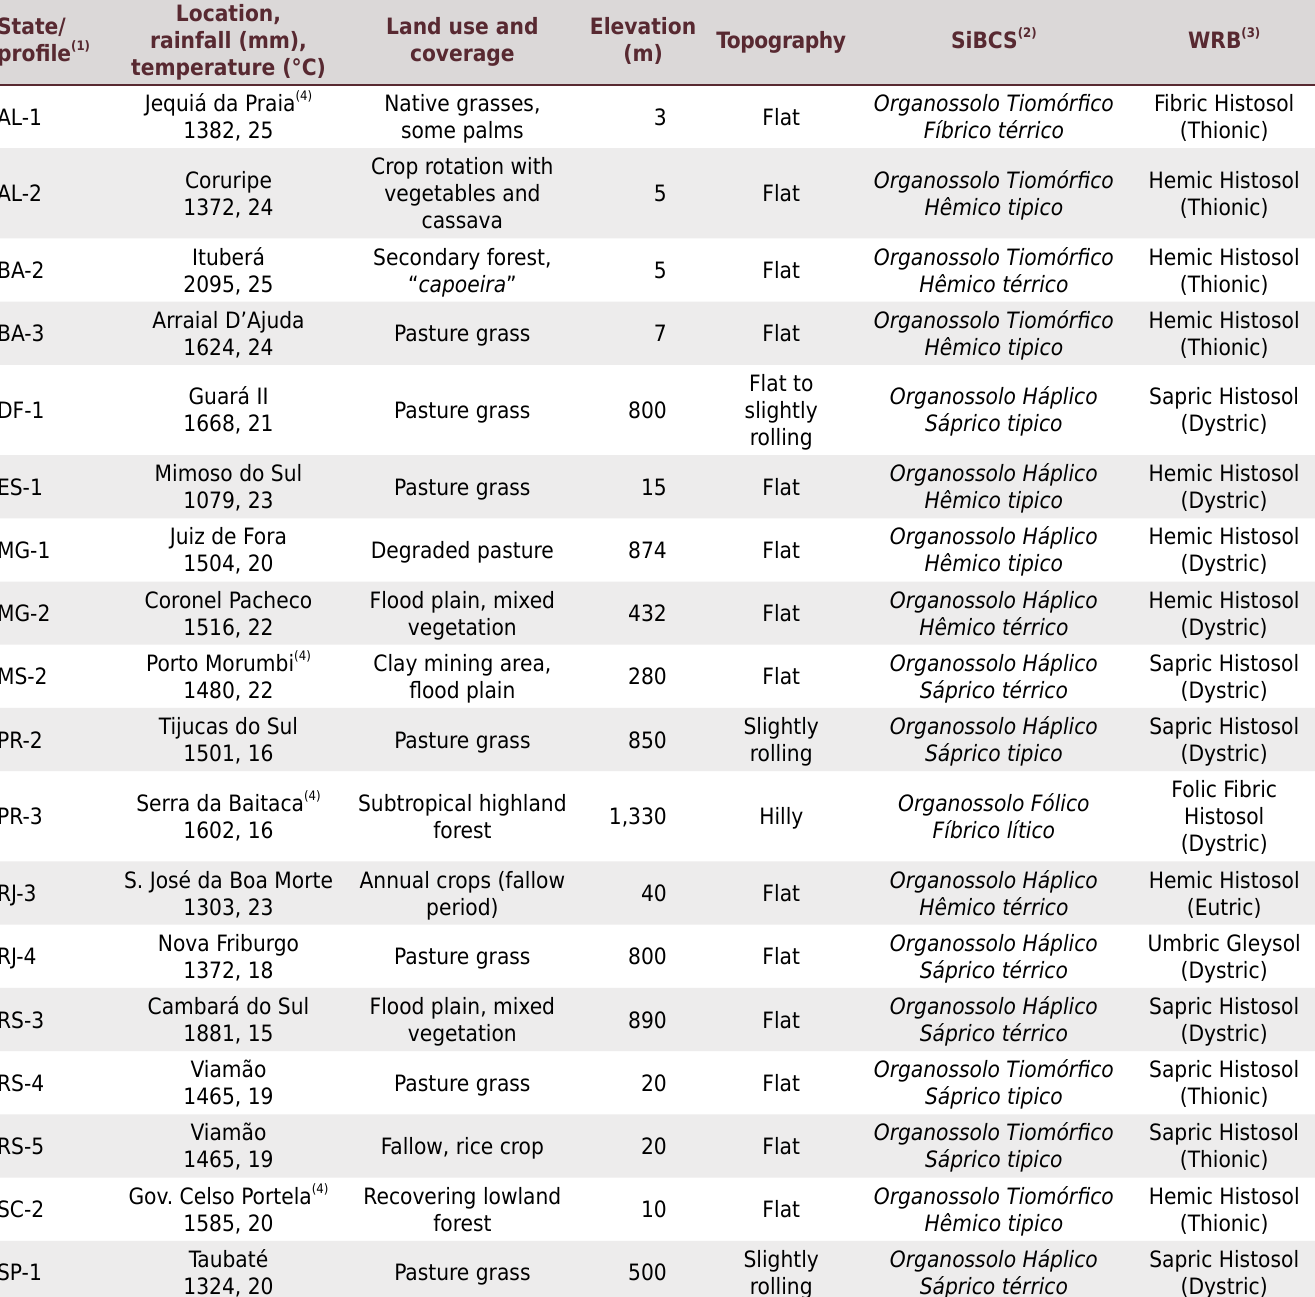
Table 1. Characterization of the sampling areas and classification of Organosol profiles